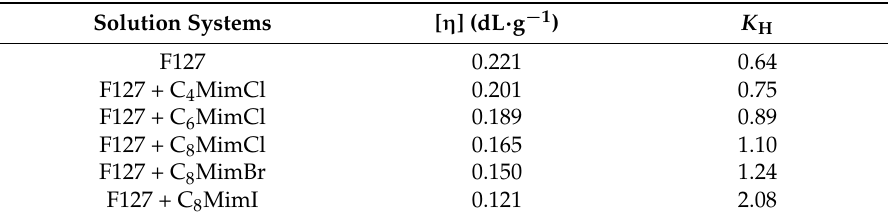
Figure 3. Concentration dependence of the reduced viscosity of F127 in presence of 100 mM ILs at 30 ◦ C; ( a ) influence of chain lengths, ( b ) influence of anion. Table 3. Effect of ILs on the intrinsic viscosity [ η ] and Huggins constant, K H , for F127 at 30 ◦